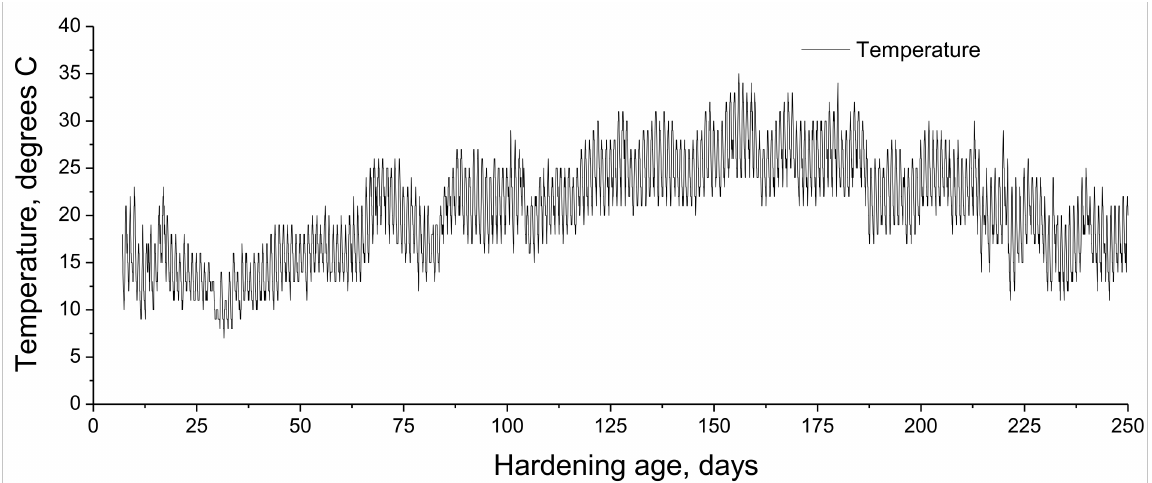
Figure 2. Temperature registered in the exposure station along the time period studied.